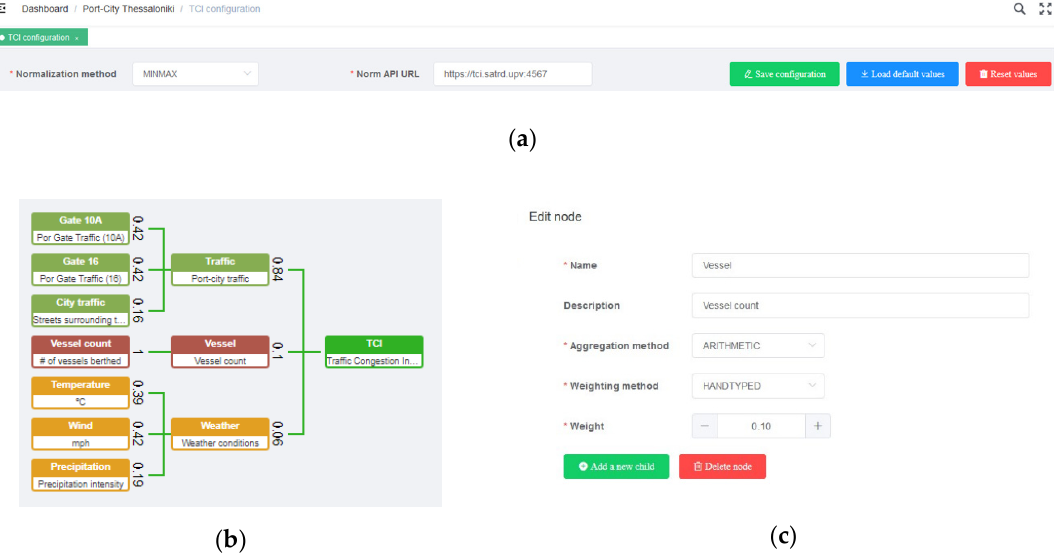
Figure 15. Composite indicator configurations: ( a ) normalization method and API; ( b ) tree structure creation, from results of Section 3.4.2; ( c ) configuration for each node of the TCI tree.